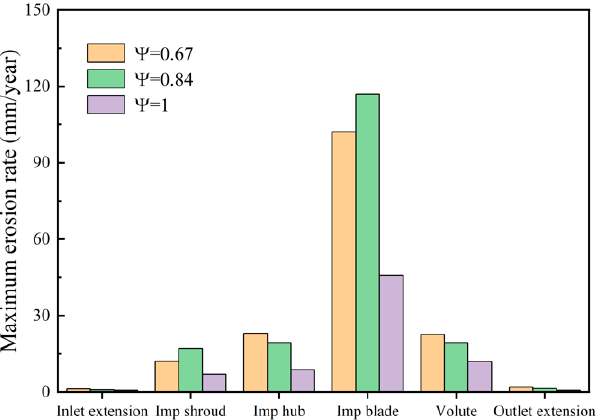
Figure 17. Maximum erosion rates on different components of the pump with particles of different shapes.